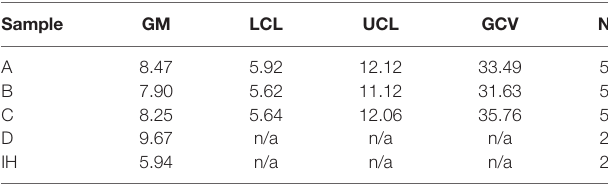
TABLE 7 | Summary of ED50 estimates (ng) for selected L929 neutralization assays using a fi xed amount of TNF- a (20IU).